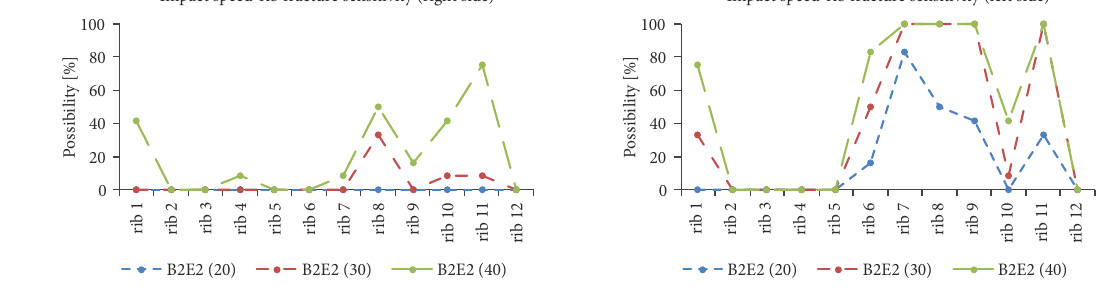
Figure 7. Influence of impact speed on fracture risk results of each rib Table 3. Predict risks of certain number of fractured